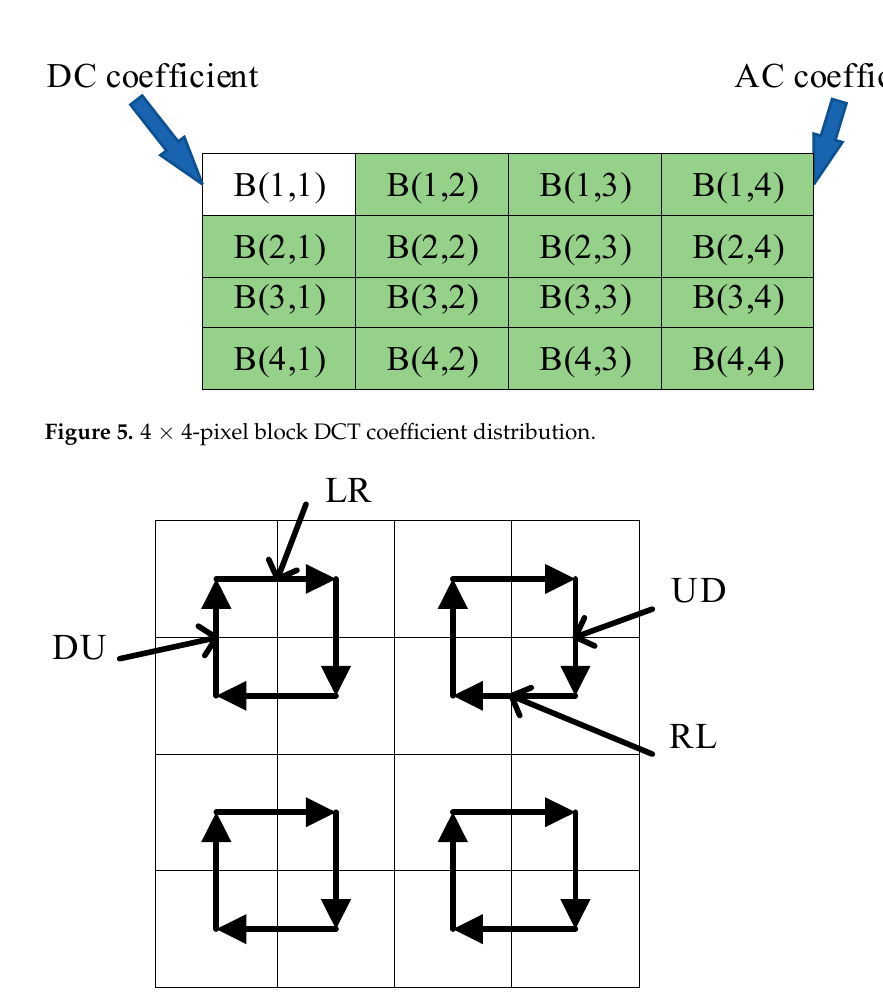
Figure 5. 4 × 4-pixel block DCT coe ffi cient distribution.